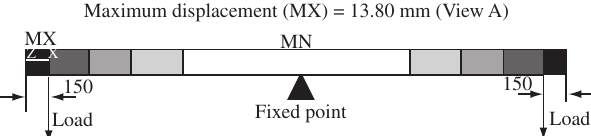
Figure 2. Example of ANSYS cross-arm simulation, in which a force of 5.49 kN (560 kgf) was applied at the two points indicated (View A).